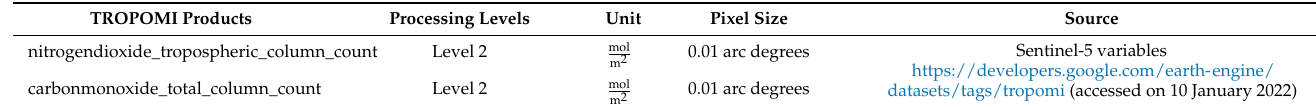
Figure 1. The study area and the selected cities (Tehran, Mashhad, Isfahan, and Tabriz) for assessing the effects of COVID-19 spread on air pollution. Table 2. The detail of the Sentinel-5P TROPOMI products used in this